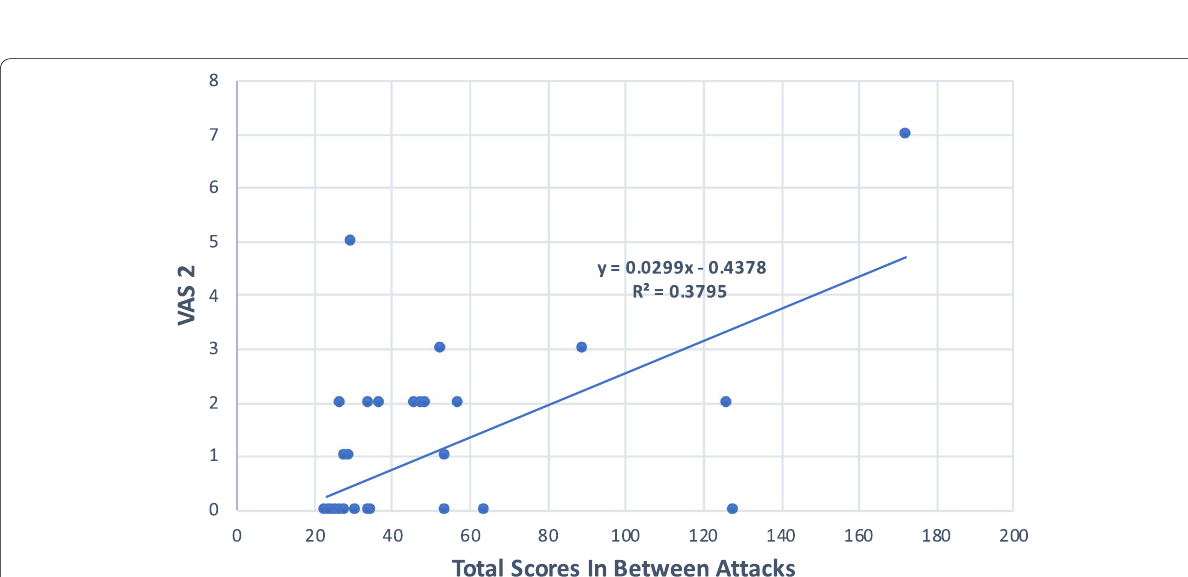
Fig. 3 Correlation between VADL scores and VAS scores in between the attacks. VADL, Vestibular Disorder Activities of Daily Living Scale; VAS, Visual Analog Independence